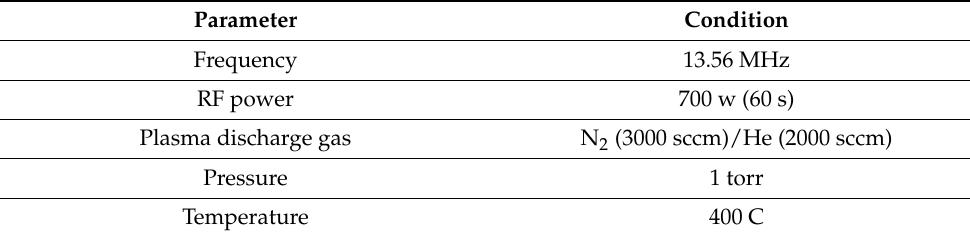
Table 2. Experimental conditions for plasma